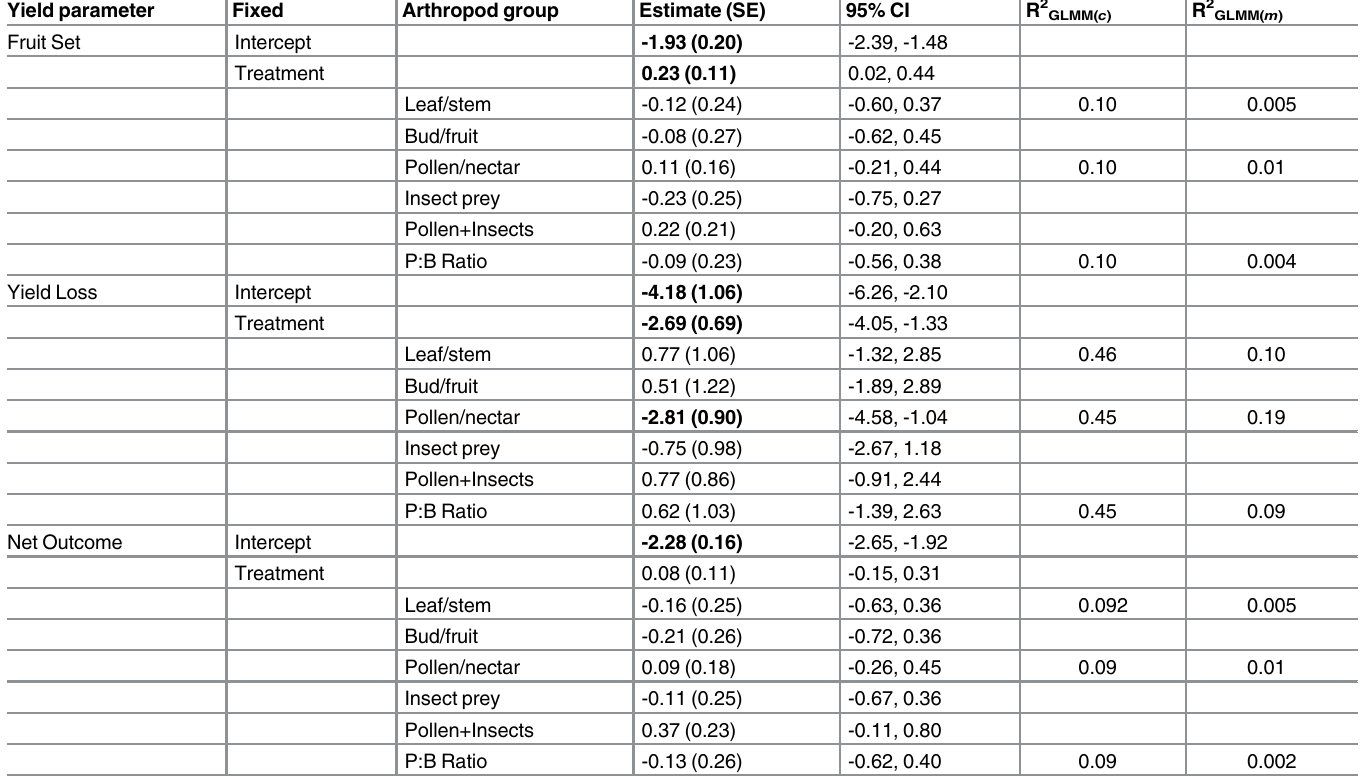
Table 1. Model parameters for generalised linear mixed models (GLMMs) examining relationships between yield parameters, vertebrate exclusion treatments (Treatment), arthropod feeding groups and the pest:beneficial arthropod ratio (P:B ratio). Yield